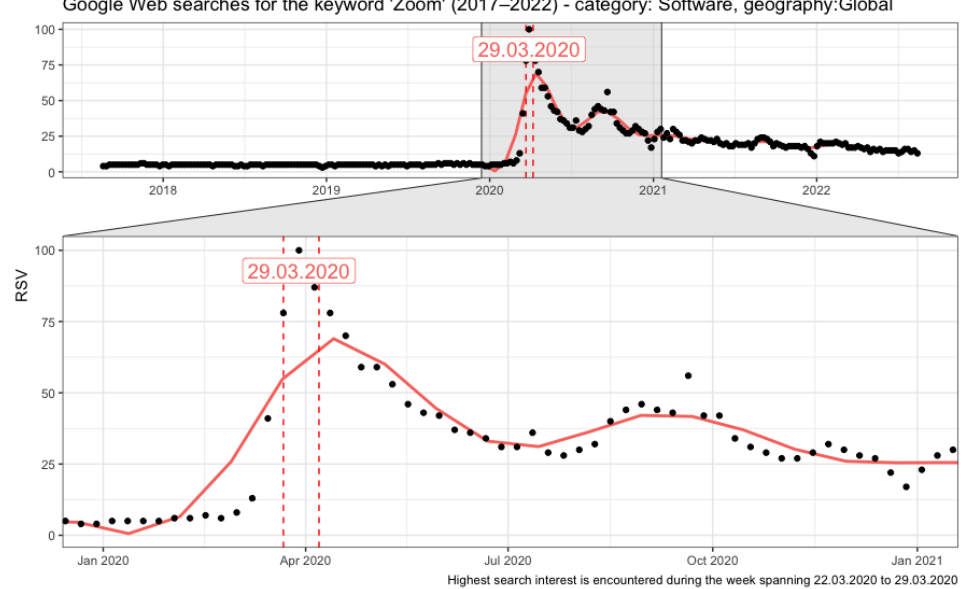
Figure 3. RSV for the keyword “Zoom”, Category “Software”, Geography “World” (July 2017 – July 2022) (above); Zoom in over 2020; Loess smoothing is applied (below); Created with the ggplot2 package in R environment with GT data sourced with the gtrendsR package.